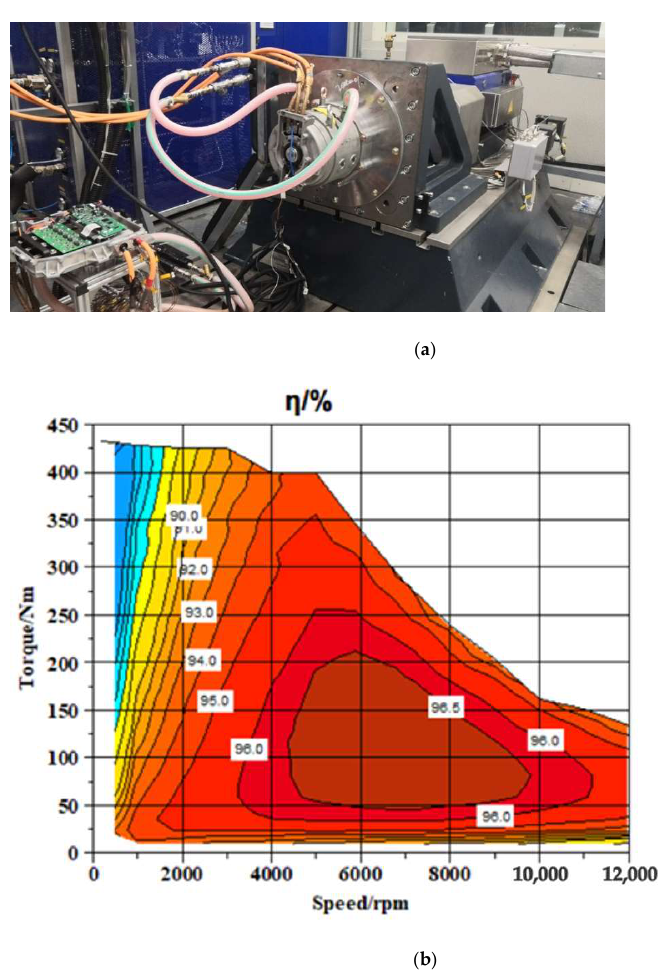
Figure 16. Electromagnetic structure of prototype motor.